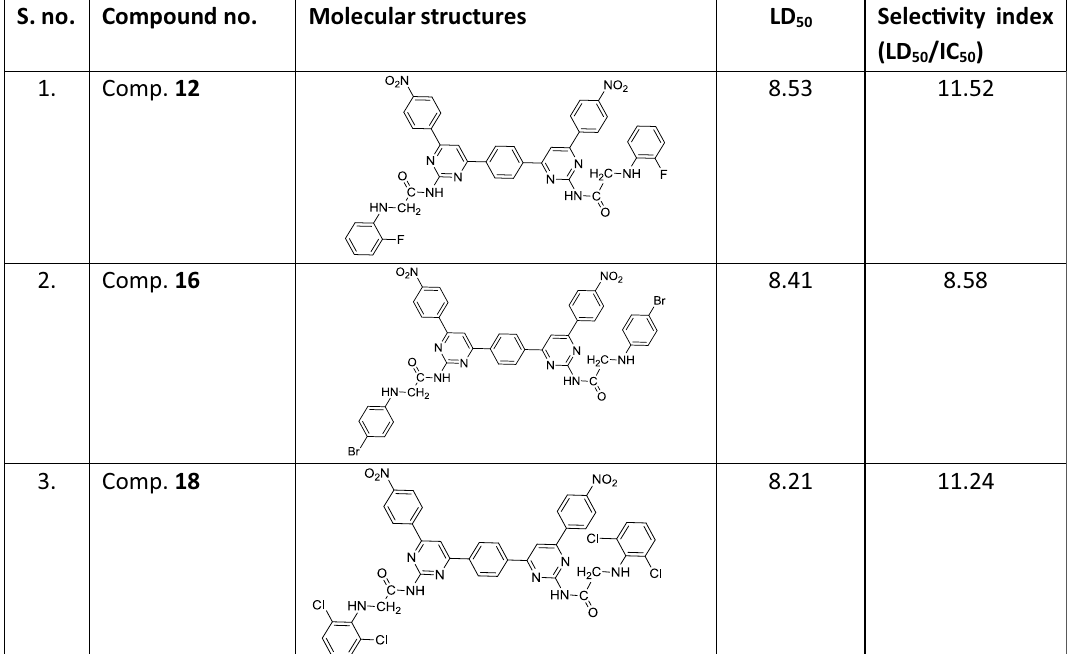
Table 5 Lethal dose (LD ) and selectivity index calculation of most active compounds 50 S.